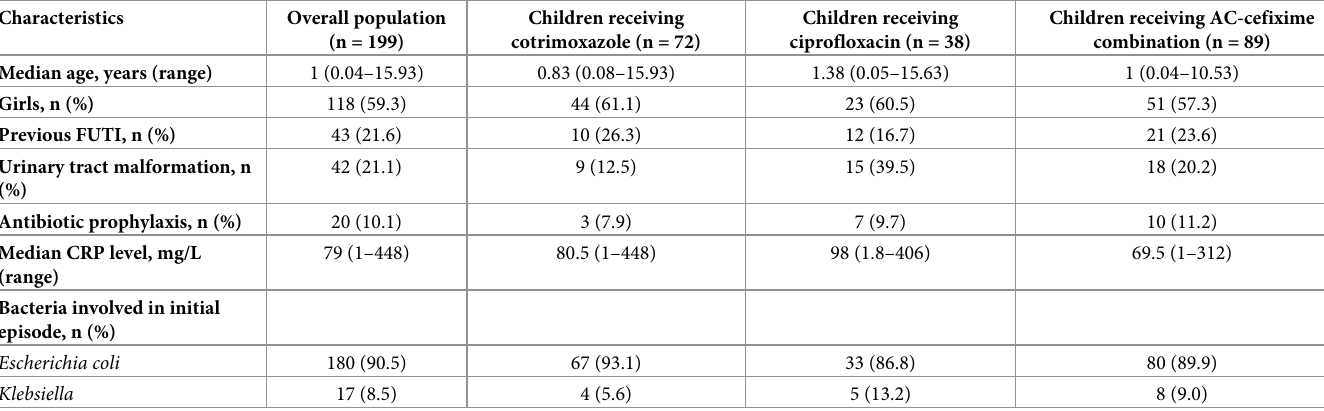
Table 1. Baseline characteristics of study